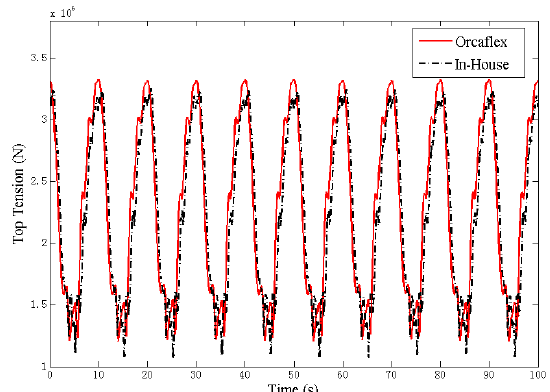
Figure 10. Multicomponent mooring line under the vertical harmonic excitation.